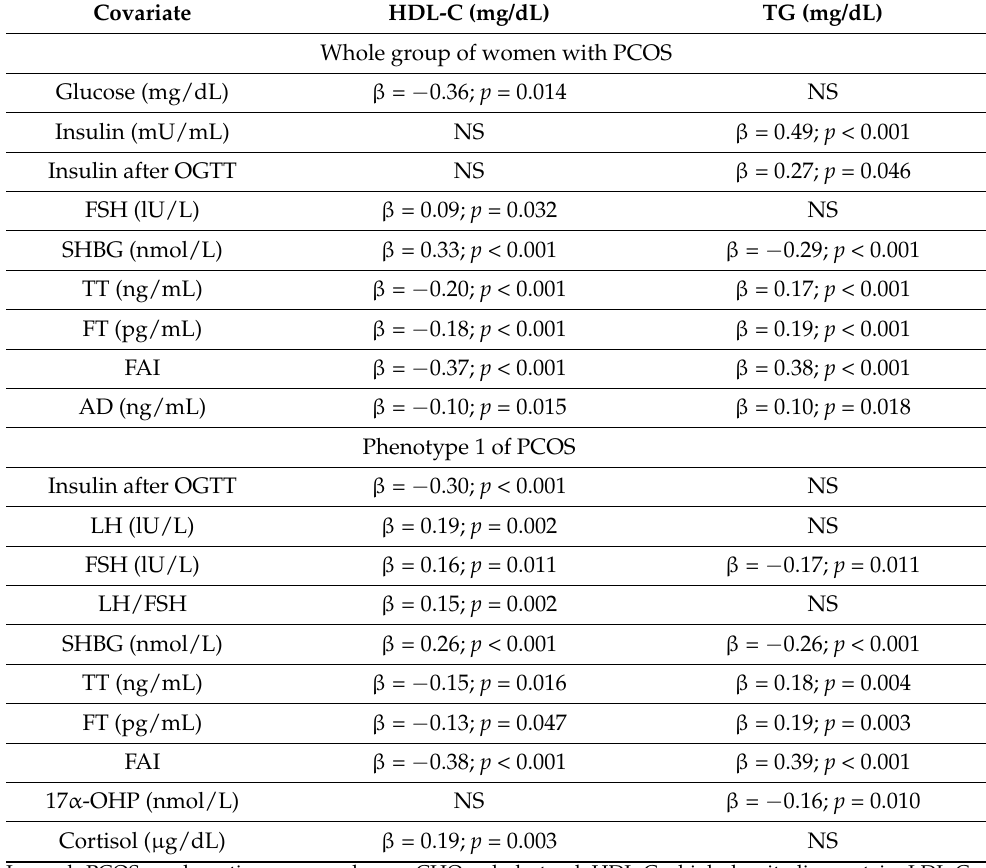
Table 4. Univariate regression analysis in the whole group of women with PCOS and in the subgroup with phenotype 1.